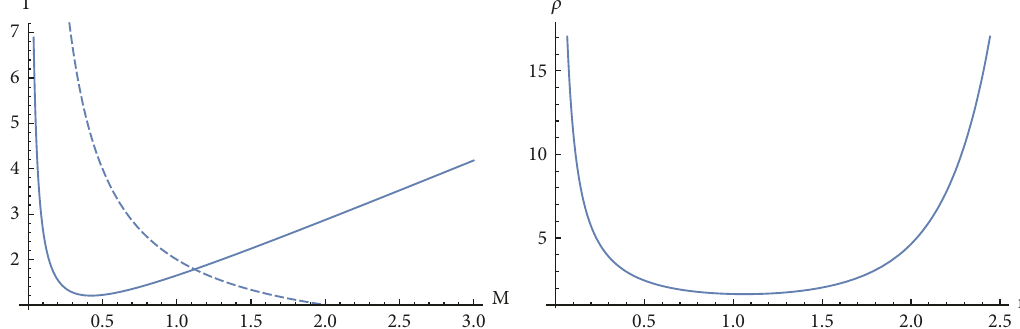
Figure 1: Left: Temperature versus mass. The solid line shows the qualitative behavior of the relation (53) while the dashed line refers to the conventional temperature of the Schwarzschild black hole. Right: the density of the matter distribution versus 𝑟 . The figures are plotted for 𝜆 = 0.1 and 𝑀 = 1 .